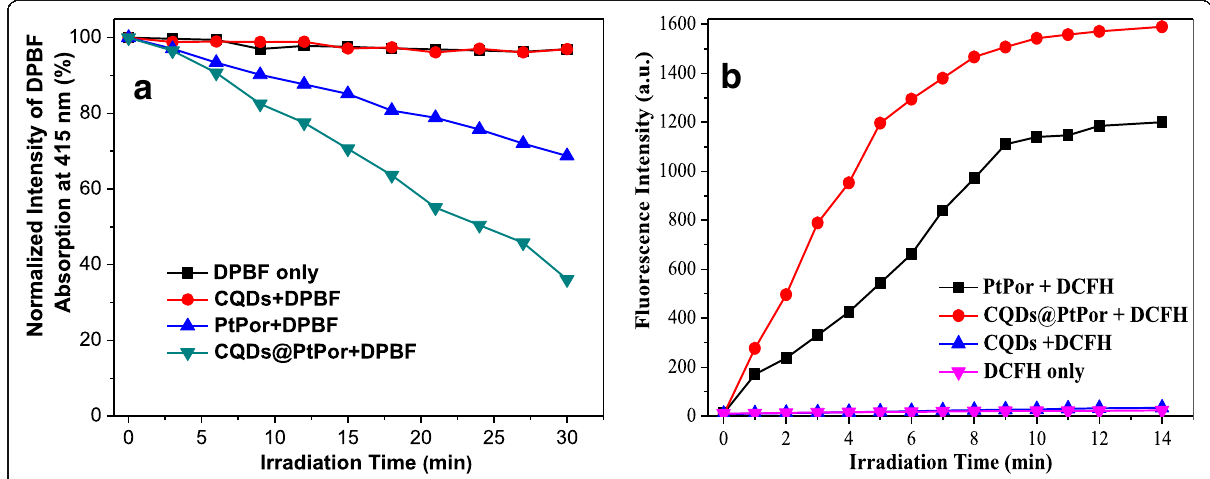
Fig. 5 Singlet oxygen generation of CQDs, PtPor, and CQDs@PtPor from DPBF method ( a ) and DCFH method ( b